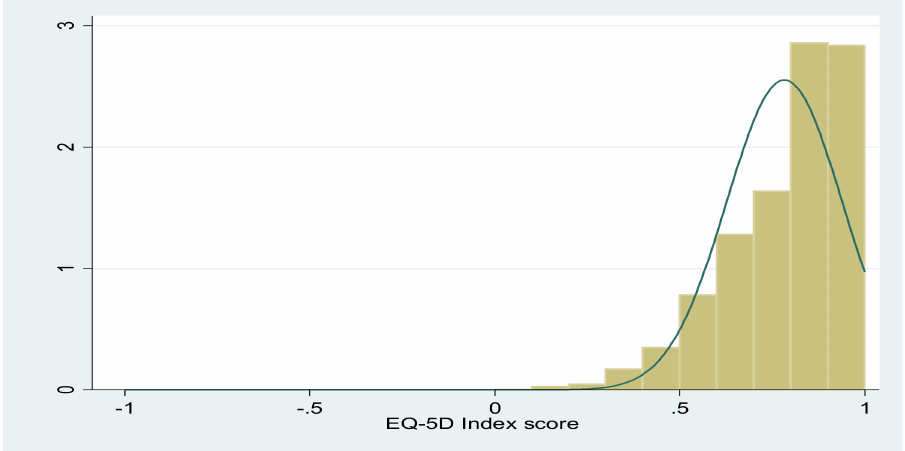
Figure 1. Distribution of the EQ-5D index scores by density.